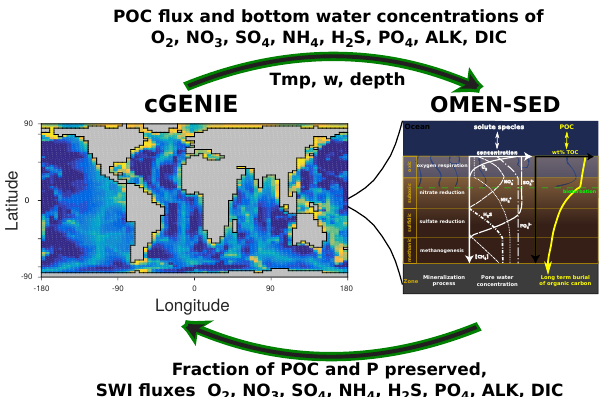
Figure 9. Schematic of the relationship between OMEN-SED and cGENIE. Arrows represent the information transferred between